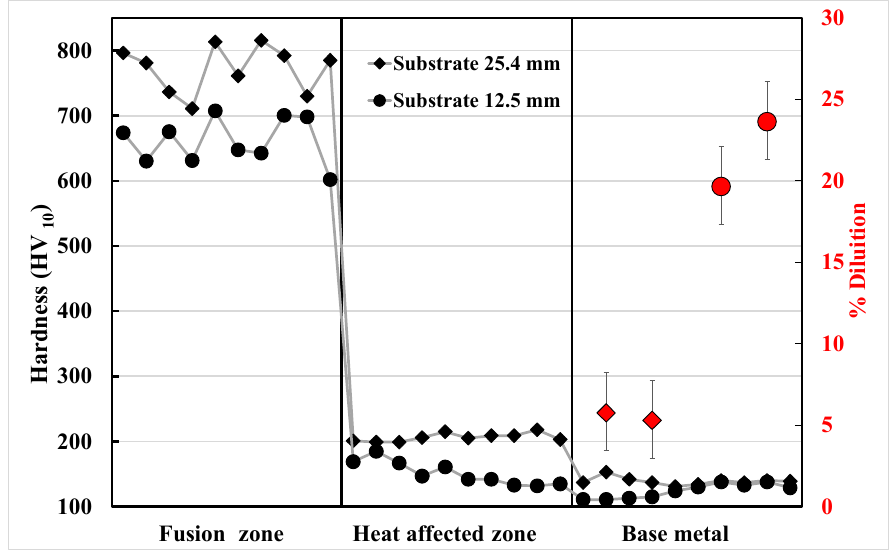
Figure 4. Average percentage of dilution of A11 hardfacings (thicknesses 25.4 mm and 12.5 mm).